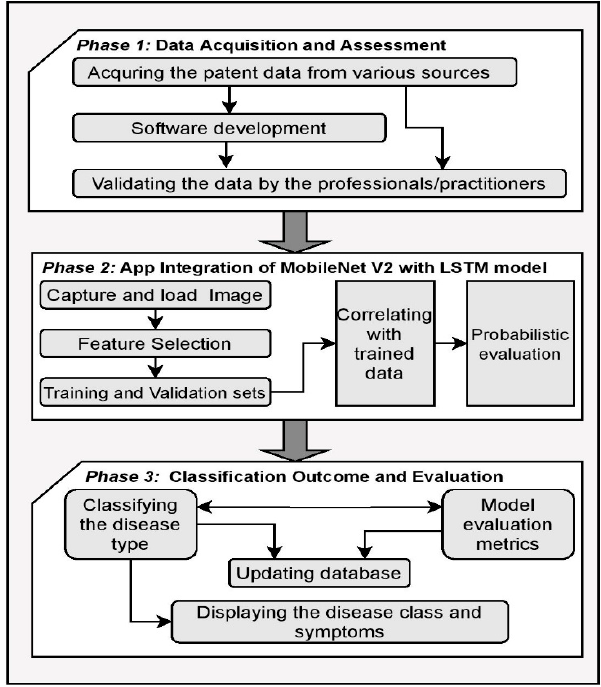
Figure 15. The mobile framework on incorporating MobileNet V2 with LSTM.